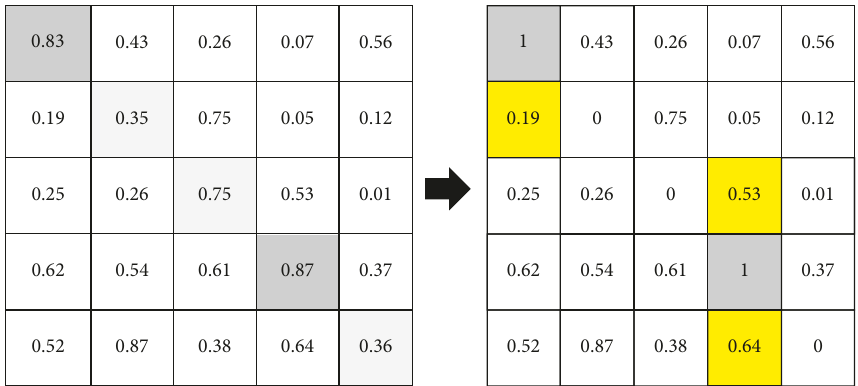
Figure 5: Solution representation.